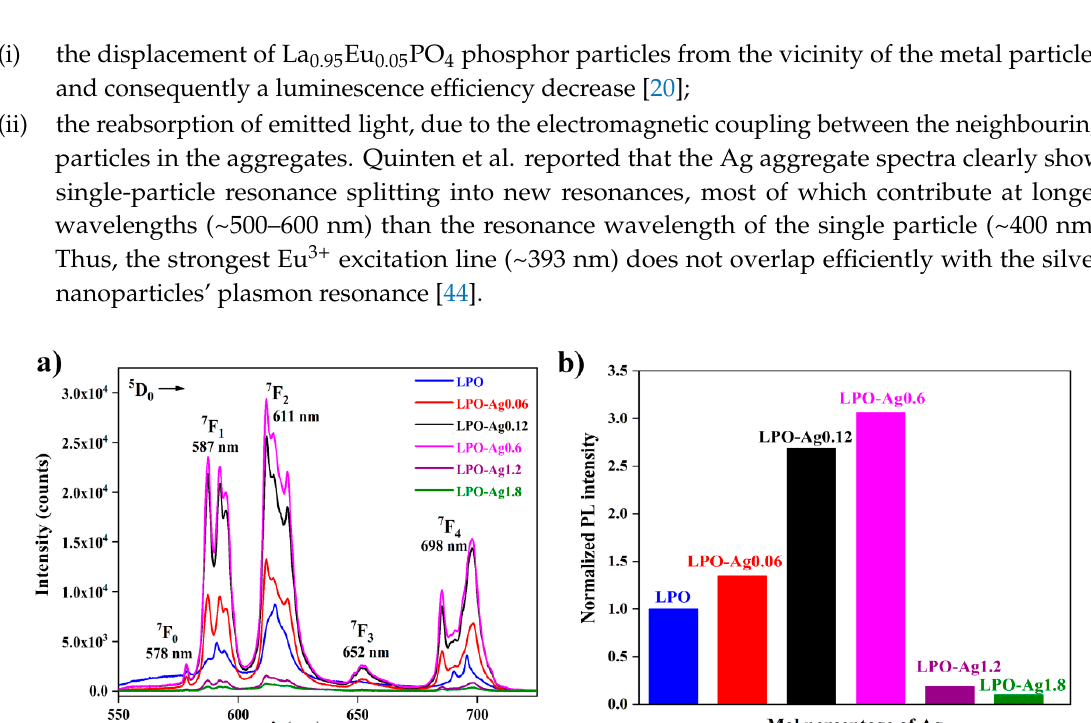
Figure S1: UV–VIS absorption spectra of the di ff erent concentrations of silver colloids, Figure S2: Distribution of the square of the electric field amplitude (E / E 0 ) 2 for 6 nm spherical Ag nanoparticles (NPs) in (a) water and in (b) La 0.95 Eu 0.05 PO 4